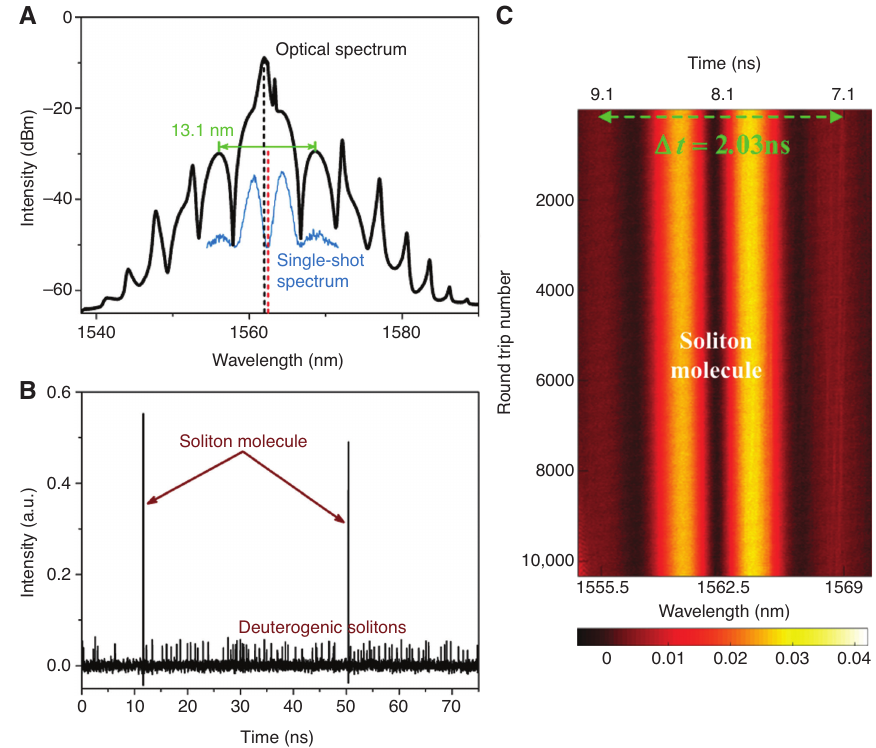
Figure 3: Composite regime of soliton molecules and deuterogenic solitons. (A) Optical spectrum measured by OSA under a pump power of 105 mW; inset is a typical single-shot spectrum of soliton molecule. (B) Pulse train. (C) The spatio-spectral evolution of soliton molecule based on the TS-DFT